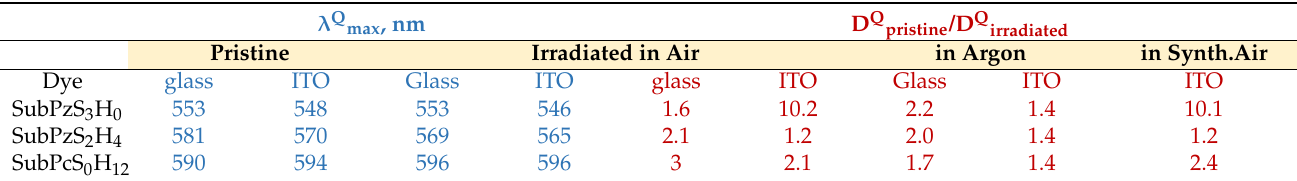
Figure 5. Absorption spectra of thin films of compounds in Figure 1 before (left) and after exposure to the direct sunlight in air (middle) and argon (right). The molecular structures of pigments are shown in Figure 1. ( a ) On glass; ( b ) On glass/ITO. Table 3. Maximum of Q-band ( λ Q max , nm) and ratio of the optical density at λ Q max in pristine and direct-sunlight-irradiated films (D Qpristince /D Qirradiated ) of three dyes (Figure 1) deposited on glass and glass/ITO substrates.